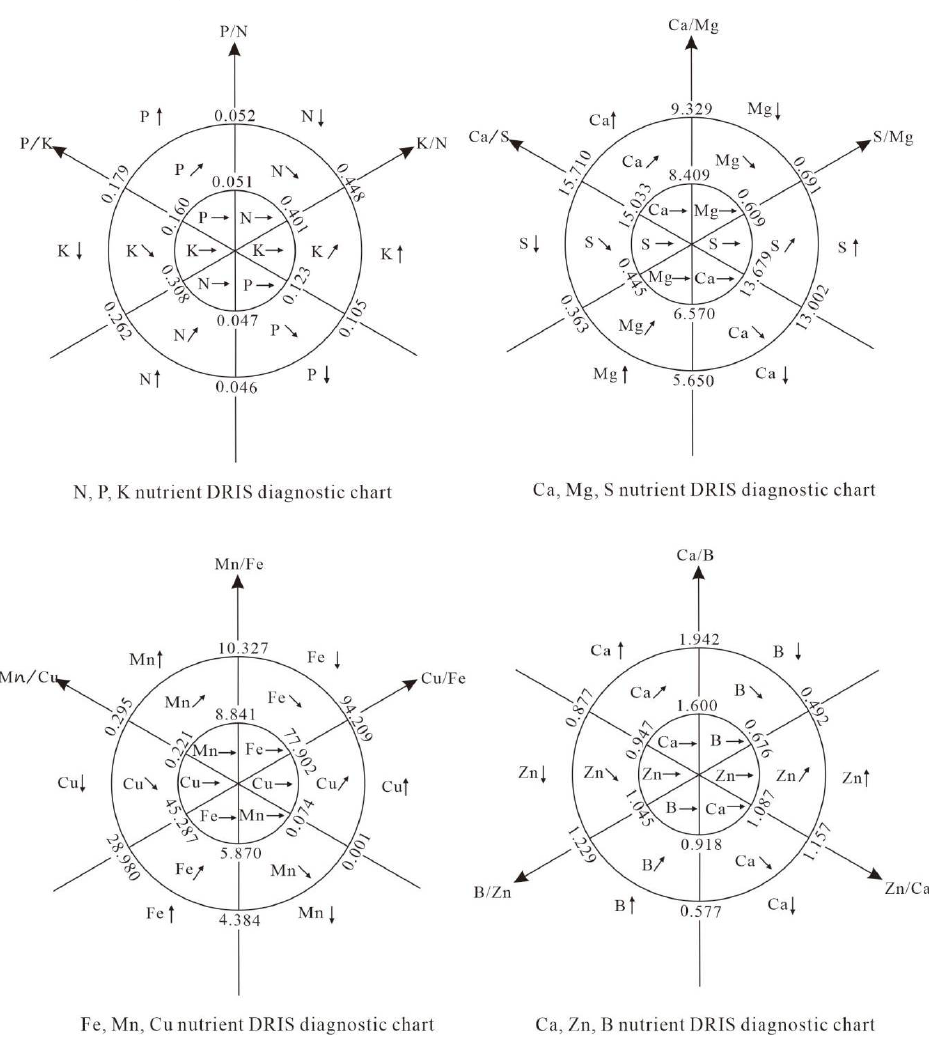
Figure 4. The Diagnosis and Recommendation Integrated System (DRIS) diagnostic map of the different nutrients in the Tainong mango leaves. The three elements of N, P, and K were selected as the important ratio parameters as P/N, K/N, and P/K, and the three ratio averages of 0.049, 0.355, and 0.142 were used as the center of each circle, respectively. Then, 2/3 times the standard deviation was used as the inner orchard radius, corresponding to the inner orchard radii of 0.002, 0.047, and 0.018, respectively; and 4/3 times the standard deviation was used as the outer circle radius, corresponding to the outer circle radii of 0.003, 0.093, and 0.037, respectively. Using P/N as an example, in terms of the P/N ratio range: 0.047–0.051, the contents of P and N were balanced; 0.051–0.052, the P content was high and the N content was low; 0.047–0.046, the N content was high and the P content was low; >0.052, there was an excess of P and a lack of N; and <0.046, there was an excess of N and a lack of P. This shows that the smaller the P/N, the greater the excess in N and lack in P. Moreover, the larger the P/N, the greater the lack of N and excess P. Similarly, the proportional relationship between P/K and K/N could be determined. The graphical method showed that the optimal ratio ranges of the